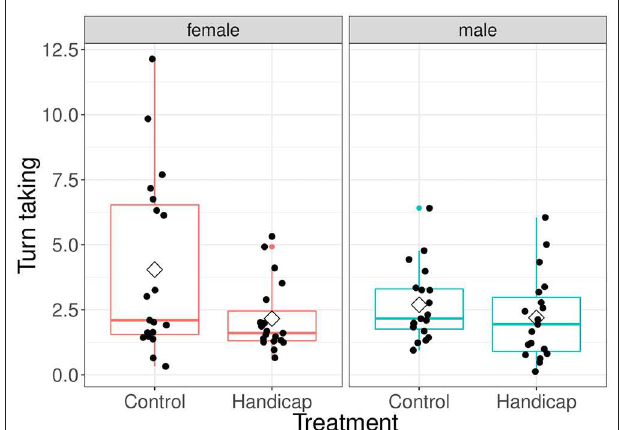
FIGURE 2 | Turn taking levels separated for treatment and for both male and female parents. Boxplot distribution with mean (diamond) and data points are represented. Sample sizes: females handicap n = 19, control n = 19; males handicap n = 19, control n = 19.